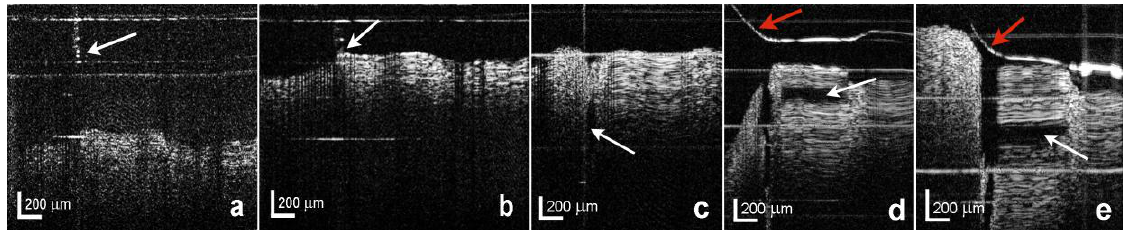
Figure 2. ( a ) Frame from a real-time OCT video of the 36-gauge needle tip (arrow). ( b ) Frame from a real-time OCT video of the 36-gauge needle tip (arrow) touching a gelatin phantom. ( c ) Frame from a real-time OCT video of the needle inserted into the gelatin phantom with early deposition of saline (arrow). ( d ) Frame from a real-time OCT video of separation of the upper gelatin layer with saline deposition (white arrow) through the 36-gauge needle. The bright line (red arrow) is the refluxed saline meniscus with expected upward curvature near the needle’s shaft. ( e ) Frame from a real-time OCT video of another separation trial of the upper gelatin layer (white arrow) with saline injection. Again, the bright line (red arrow) is the refluxed saline meniscus with expected upward curvature near the needle’s